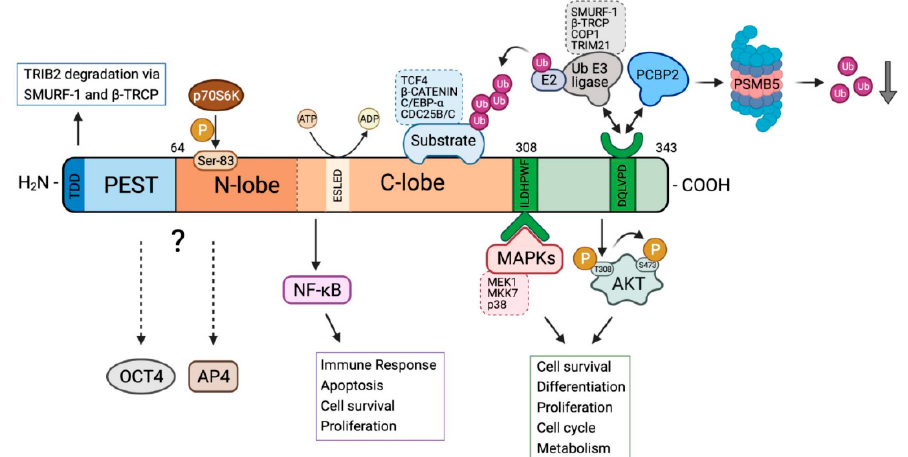
Figure 1. Structure and function of TRIB2 pseudokinase. TRIB2 is a three-domain protein containing an N-terminal PEST region (blue), a bilobed pseudokinase domain (orange) and a C-terminal tail (green). The PEST sequence and the five most N-terminal amino acids (TRIB2 Degradation Domain, TDD) are involved in TRIB2 degradation. The N-lobe of pseudokinase domain is characterized by the phosphorylation of serine 83 by p70S6K, which is also involved in TRIB2 homeostasis. The C-lobe of pseudokinase domain contains the ESLED sequence which is implicated in ATP binding and hydrolysis. The interaction of TRIB2 with NF- κ B and with substrates of the ubiquitin-proteasome system (TCF4, β -CATENIN, C/EBP α and CDC25B/C) occurs also through C-lobe of pseudokinase domain. Within the C-terminal region of TRIB2, there are two important conserved sequences: ILDHPWF sequence is involved in the interaction with MEK1, MKK7 and p38 MAPKs, and the sequence DQLVPD is related to the interaction with Ubiquitin E3-ligases such as SMURF-1, β TRCP, COP1 and TRIM21, that polyubiquitylate the substrates attached to pseudokinase domain. The DQLVPD sequence also binds PCBP2 protein, which interacts with PSMB5 proteasome subunit leading to a reduction in global ubiquitin levels. The C-terminal domain is also involved in the direct interaction with non-phosphorylated threonine 308 of AKT, which promotes the phosphorylation of serine 473 of AKT and enhances its activation. The dashed arrows indicate that it has been described that OCT4 and AP4 interact with TRIB2 but is has not been clarified with which region of the protein.